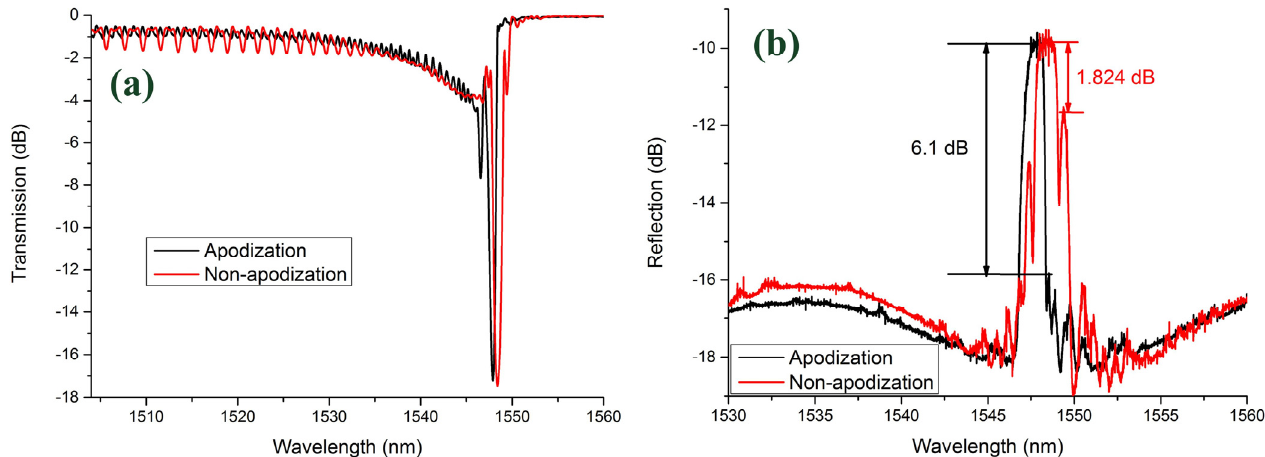
Figure 8. Comparison between apodized LBL-FBG and non-apodized LBL-FBG: ( a ) transmission spectrum and ( b ) reflection spectrum.